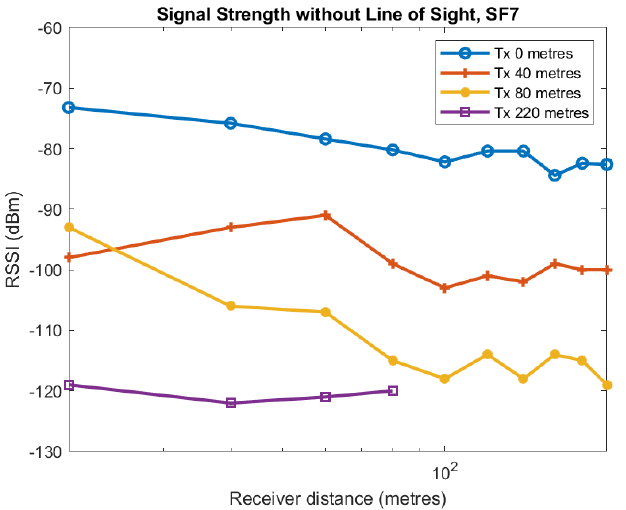
Figure 13. RSSI against log of Receiver distance from junction for different transmitter distances from junction.